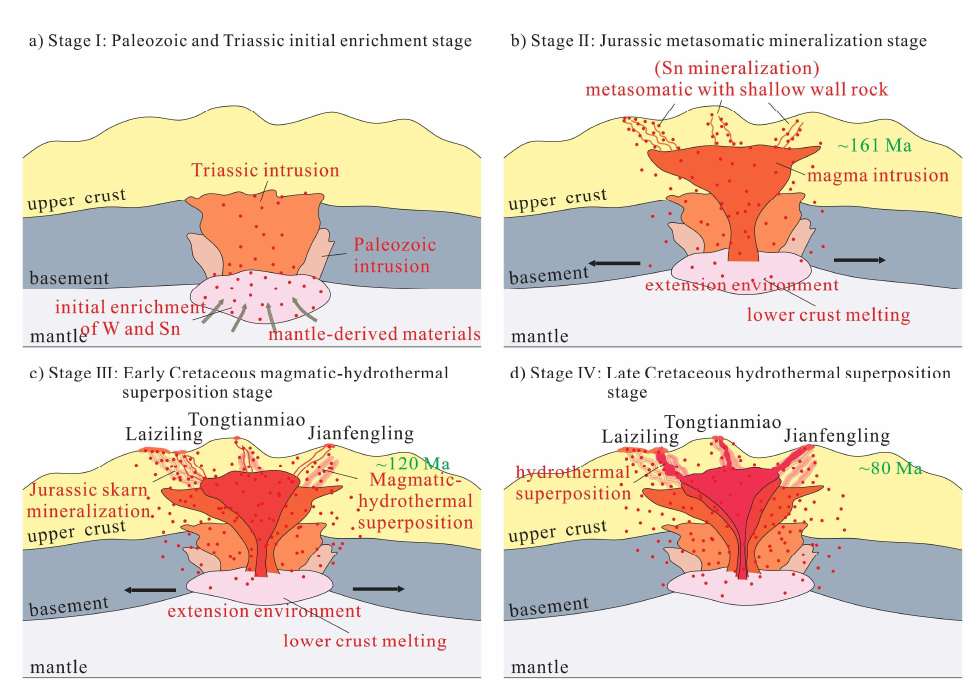
Figure 16. Schematic diagram of magmatic-hydrothermal evolution in the Xianghualing ore field. ( a ) Initial enrichment stage of ore-forming elements in Paleozoic and Triassic; ( b ) Metasomatic metallogenic stage in Jurassic; ( c ) The superposition stage of magmatic-hydrothermal fluid in Early Cretaceous; ( d ) The superposition stage of hydrothermal fluid in Late Cretaceous.